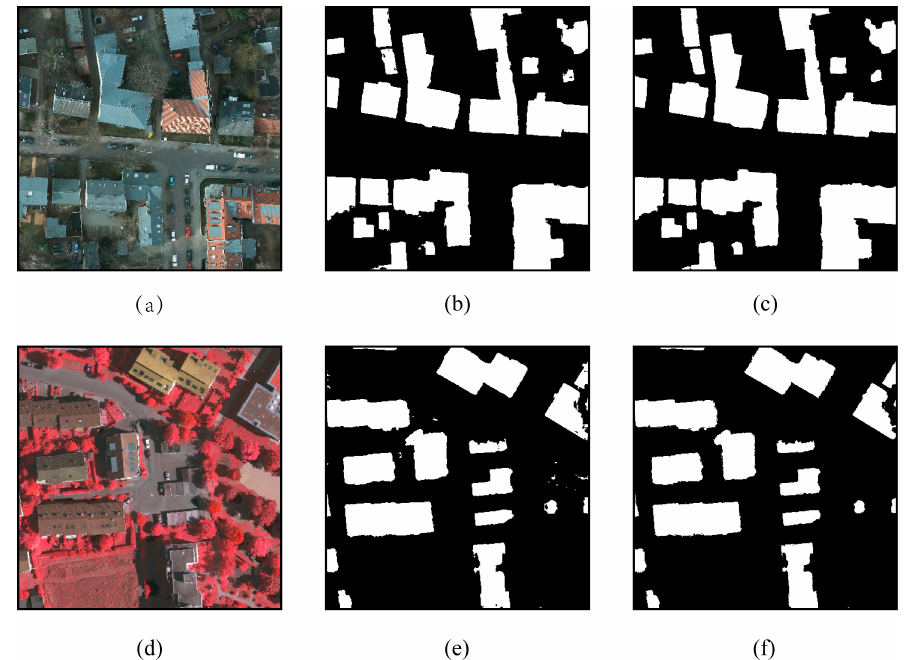
Figure 6. Results of the guided filter. ( a ) represent the original imageries in the Potsdam and Vaihingen datasets, respectively. ( b ) represent the corresponding prediction from deep learning. ( c ) represent the results of guided filter. ( d – f ) are the original imageries, prediction from deep learning and the results of guided filter in Vaihingen, respectively.